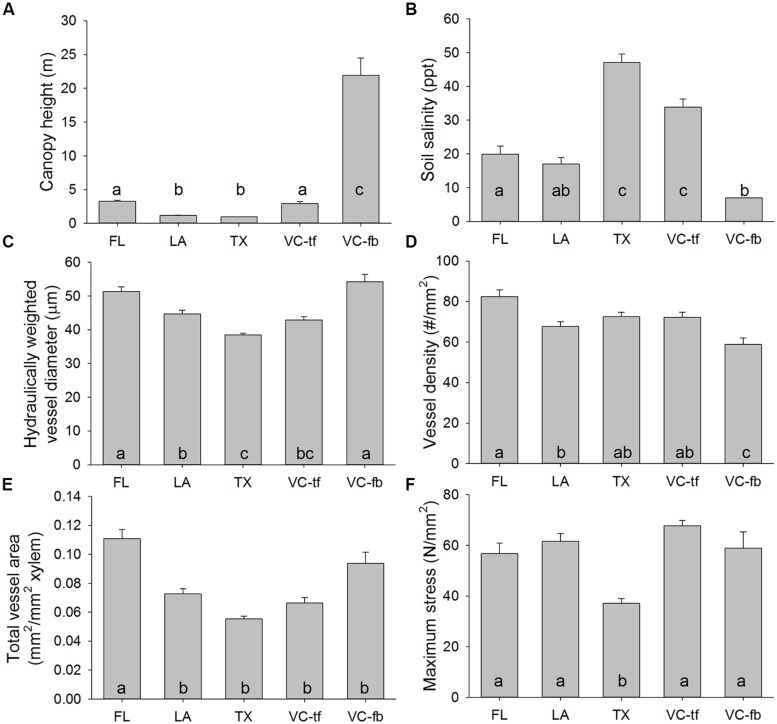
Anatomical, biomechanical, soil, and canopy features of Avicennia germinans throughout the Gulf of Mexico: Florida (FL), Louisiana (LA), Texas (TX), Veracruz tidal flats (VC-tf), and Veracruz interdistributary flood basin (VC-fb). (A) Mangrove canopy height; (B) Soil salinity; (C) Hydraulically weighted xylem vessel diameter; (D) Xylem vessel density; (E) Total xylem vessel area; (F) Maximum tensile fracture stress of mangrove branches. Error bars represent one SE. Letters indicate significant differences among regions from Tukey post hoc tests.